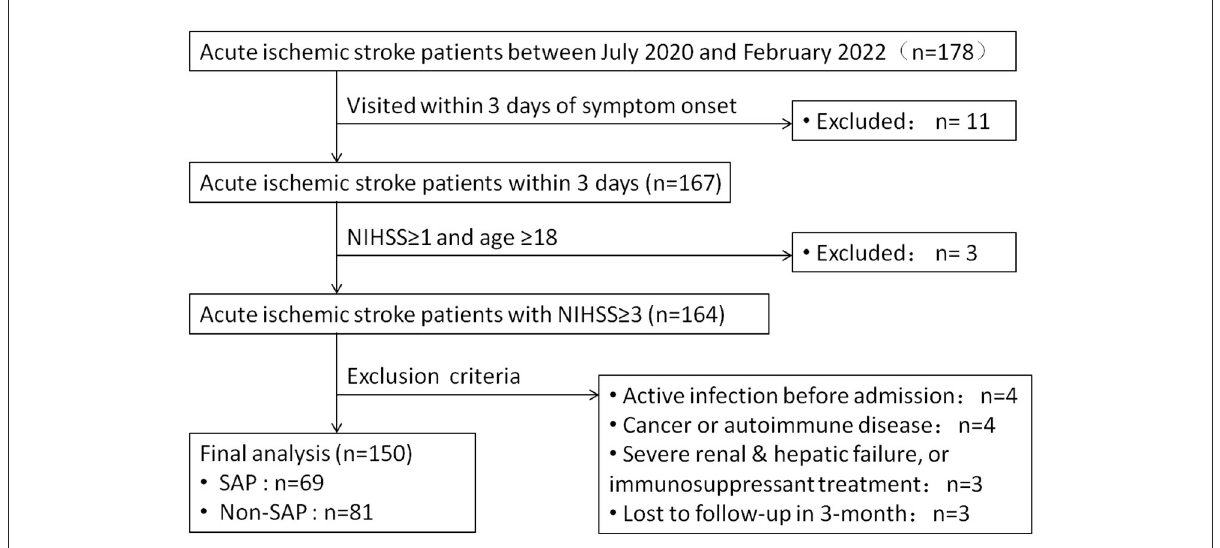
FIGURE1 Flow-chart of inclusion and exclusion criteria. SAP, stroke-associated pneumonia; NIHSS, National Institutes of Health Stroke